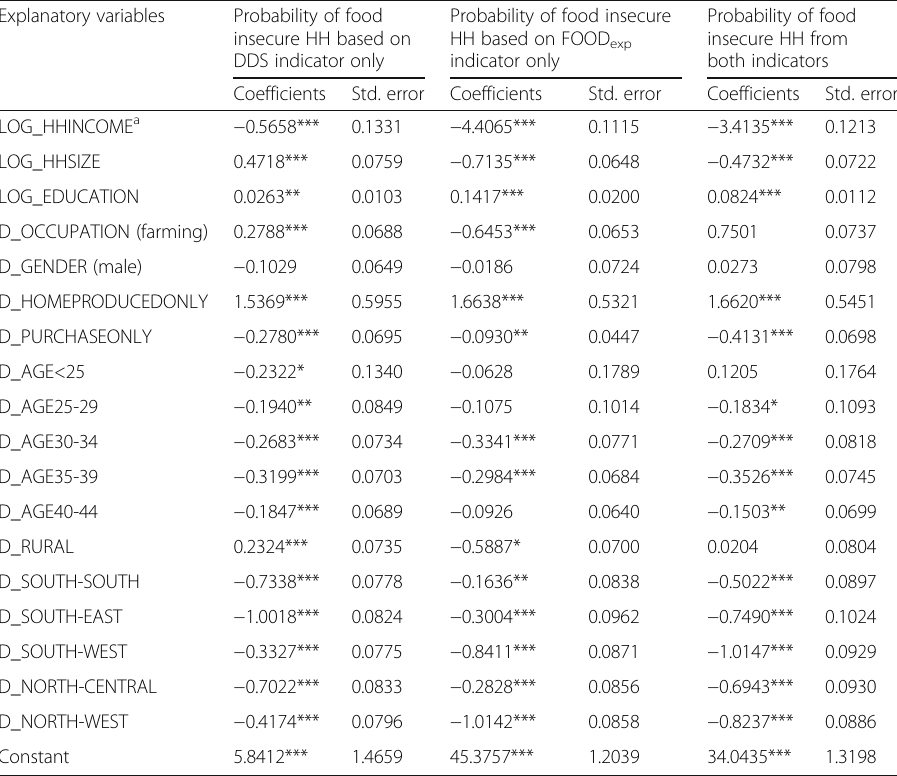
Table 3 Socio-economic and demographic determinants of households being different food- poverty states Explanatory